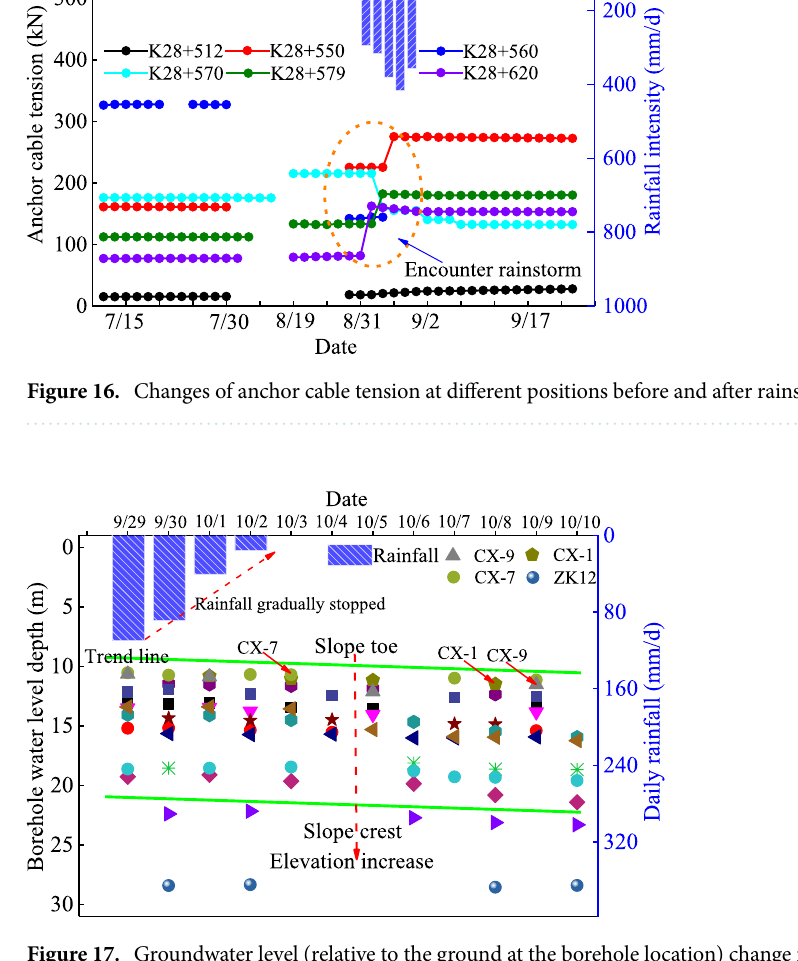
Figure 17. Groundwater level (relative to the ground at the borehole location) change in boreholes after rainfall. (Borehole location is shown in Fig.